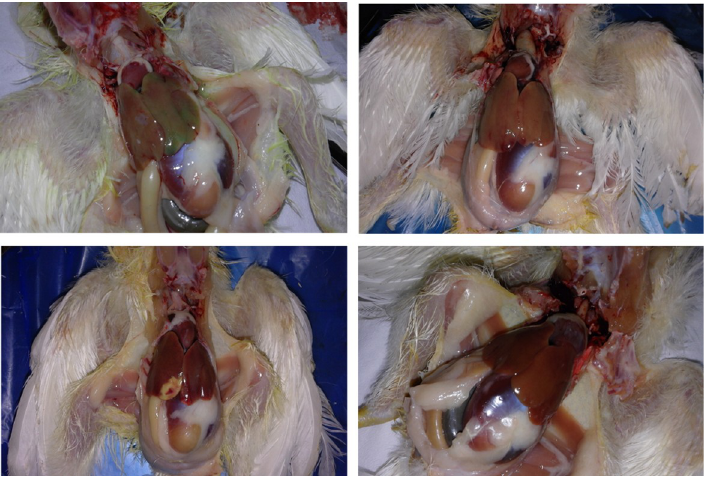
Fig 2. Gross lesions of liver in infected chickens. a: hypertrophied greenish liver of infected chicken at 9 dpi with; b: Pallor and enlargement in liver of infected chicken at 13 dpi with; c: Necrosis lesion in liver at 13 dpi; d: Normal liver of uninfected